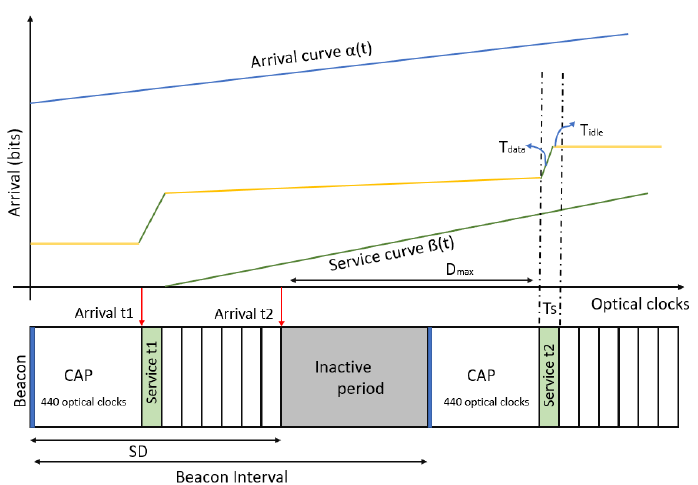
Figure 6. Service curve for Visible Light Communication (VLC) Medium Access Control (MAC)— star